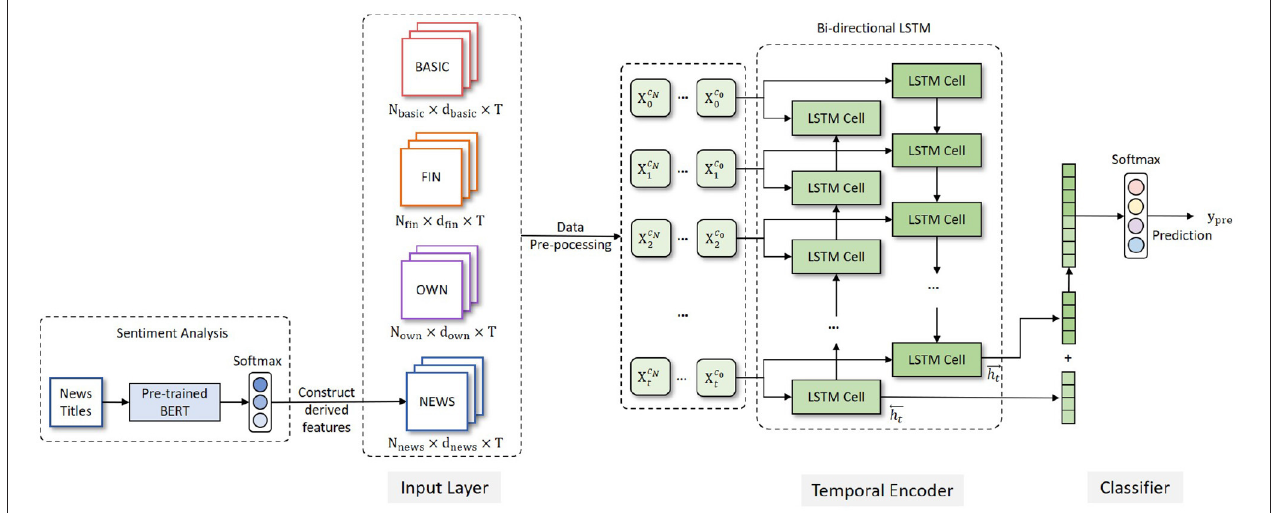
FIGURE 1 | A sequential data-based prediction framework for organization performance changes